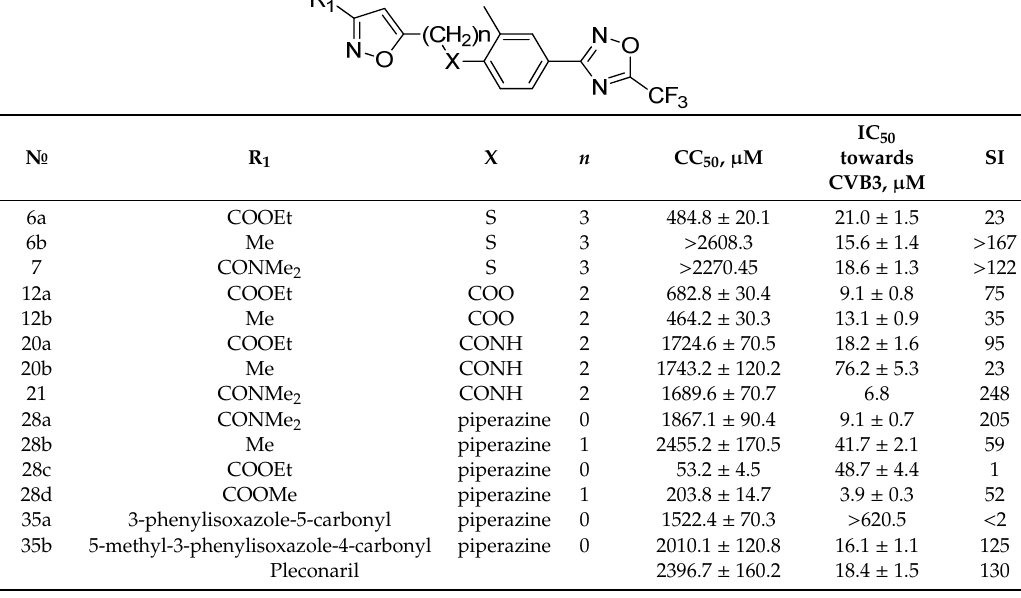
Table 1. Antiviral activity of synthesized compounds towards coxsackievirus B3 strain Nancy.